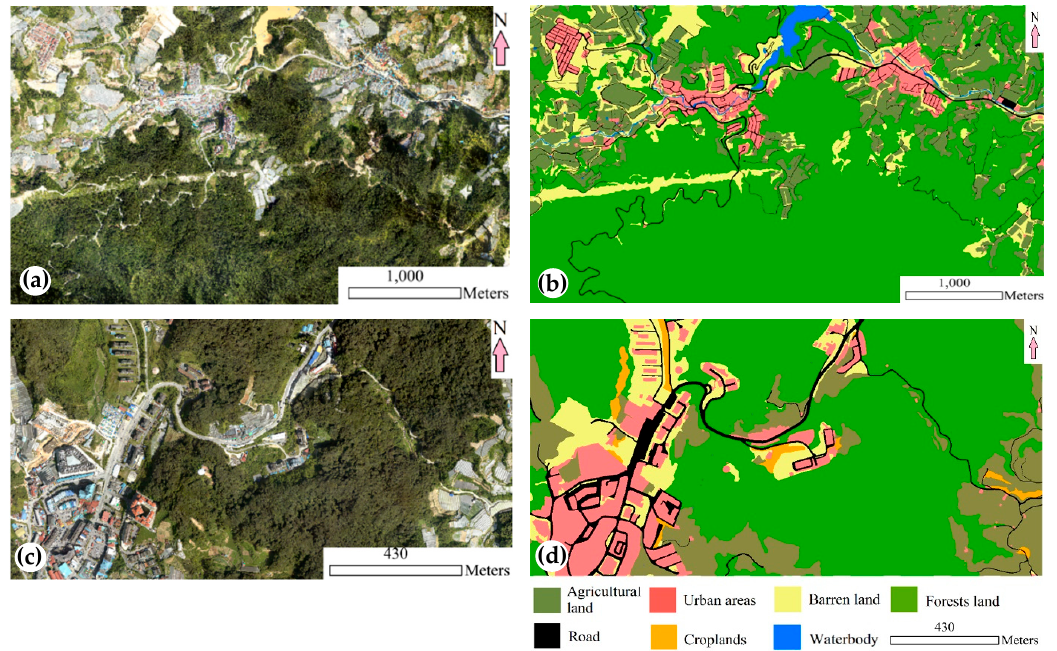
Figure 5. ( a ) Training of first dataset and ( b ) Ground truth map of the first dataset. ( c ) First test dataset and ( d ) Ground truth map of the first test